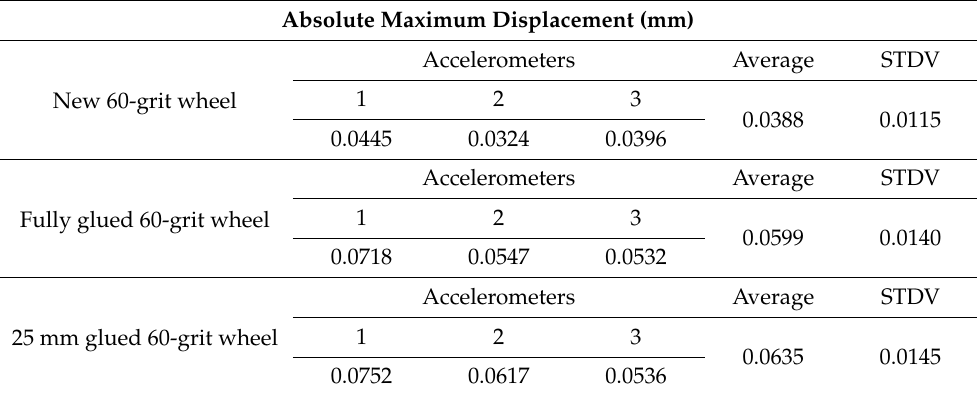
Table 2. Average and maximum displacement results of 60-grit medium-grade wheels after 60 impact hammer tests.